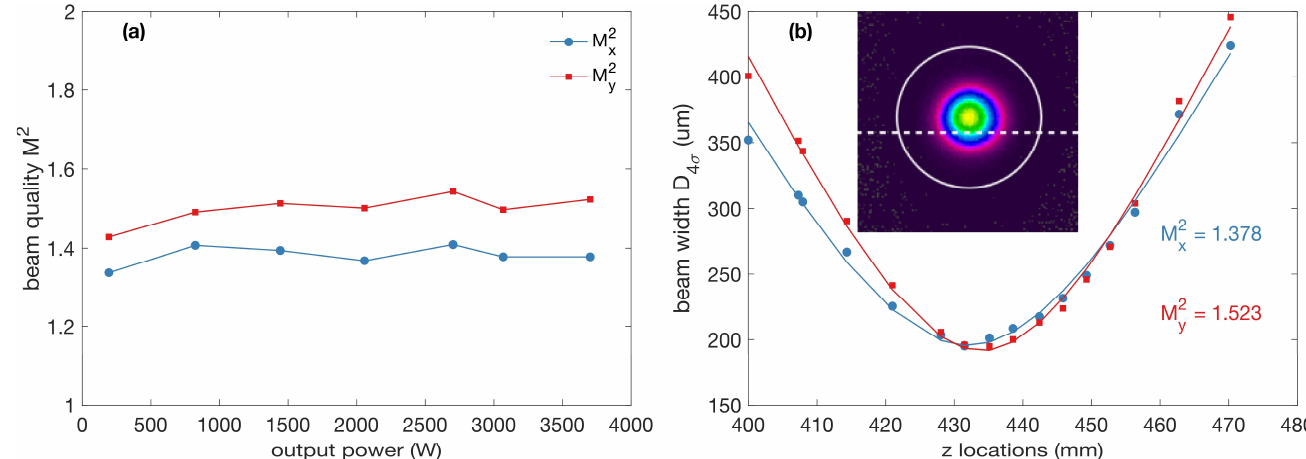
Figure 7. The beam quality of the laser. ( a ) The M 2 of the output laser at different powers; ( b ) the measured M 2 factor and the beam profile around the waist at maximum output power.